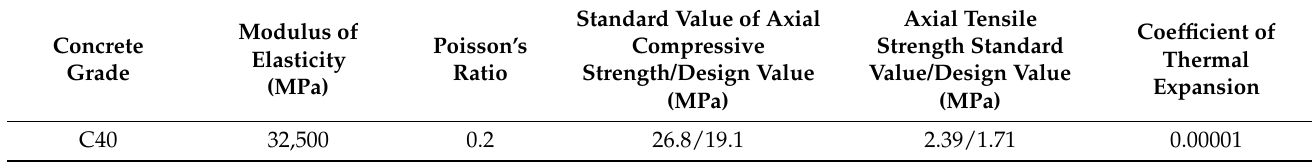
Figure 4. Full bridge model diagram. Table 1. Bridge deck modeling parameters.